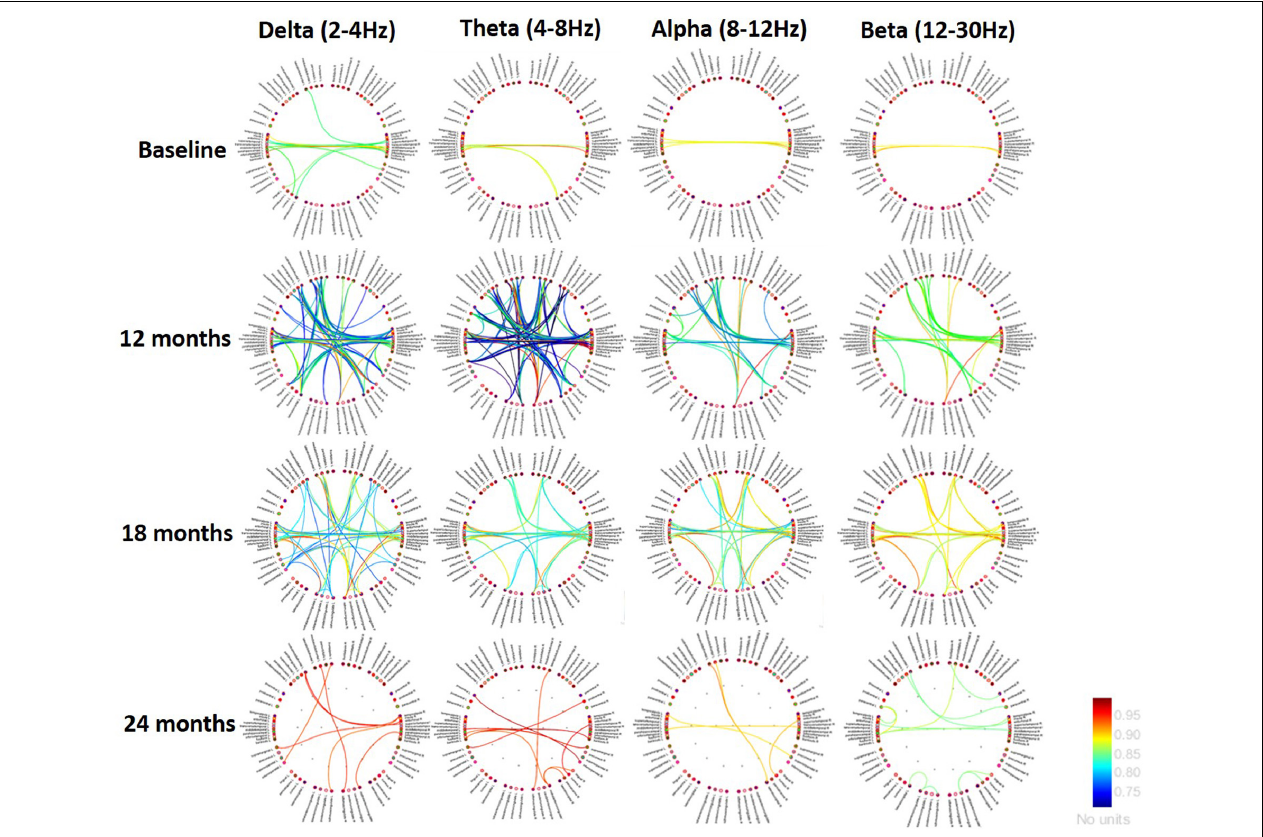
FIGURE 3 | Changes in brain connectivity from the initial study to the end of follow-up (24 months). Red and yellow lines indicate an increase in connectivity, while the blue lines show a decreasing pattern. Functional connections predominate in the bilateral mid-temporal regions with cingulate areas and, to a lesser extent, with frontomedial and orbitofrontal areas. In other words, the connectivity between the temporal and limbic areas remains quite strong. Low frequencies show an earlier decrease in connectivity, but the latest studies would indicate a pattern of reorganisation of